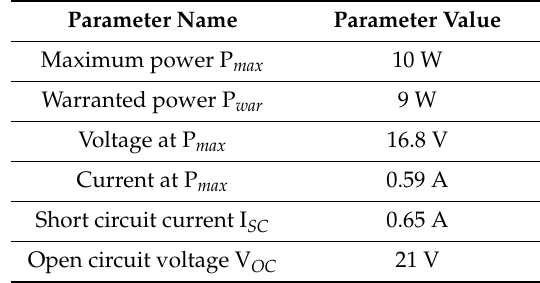
Table 3. Parameter values of BP SX-10 [18].